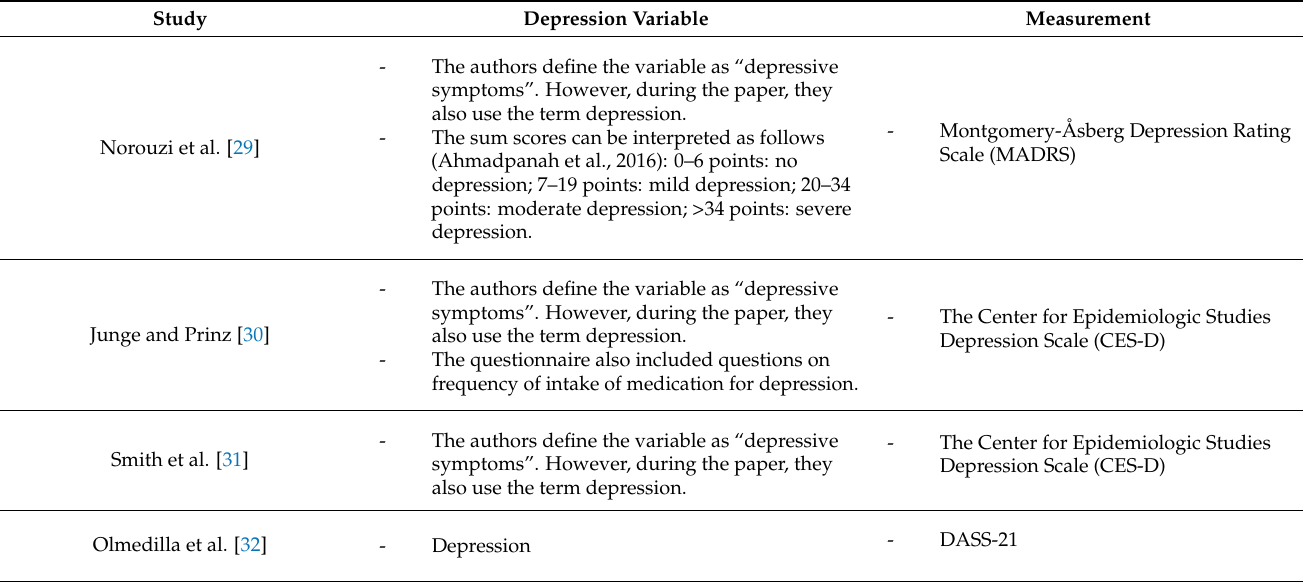
Table 4. Definitions used in the depression variable and evaluation instrument